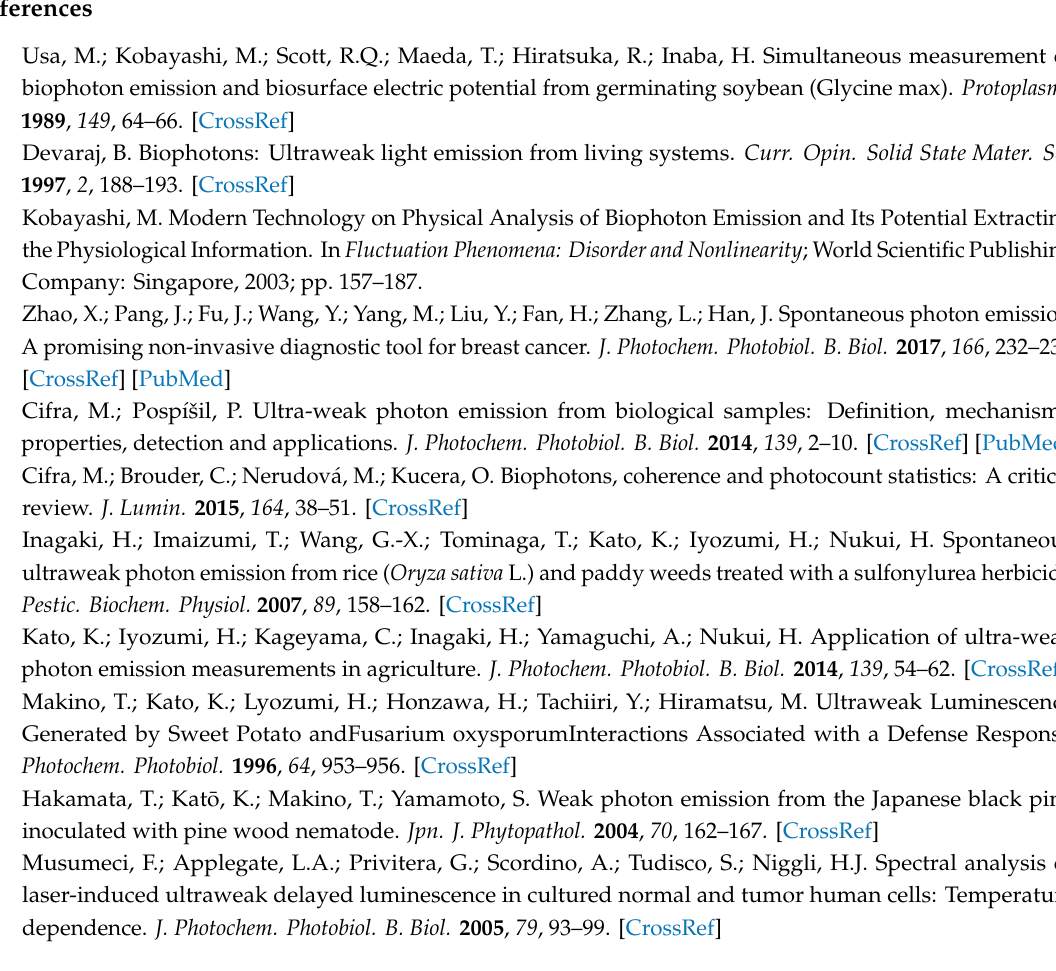
a 30 min accumulation time for each frame (total images: 7). The plants were dark-adapted under weak green light for a period of 2 h before the measurement. Mechanical injury was done under weak green light and plant was further kept in complete darkness for 30 min before measurement. Figure S3: Delayed luminescence from Arabidopsis leaf and its decay monitored for 30 min. The data show the level of dark count and background noise of the PMT (grey box). The arrow indicates the point at which the PMT shutter was closed to assure that the level of noise does not change with time. Figure S4: Biological replicates showing the fluctuation in delayed luminescence. The red dot in A and B indicates mechanical injury. The grey box in B shows opening and closing of the dark box during the measurement to make sure that no external noise was created during the process of wounding. All other conditions remain as in Figure 3C. Table S5: Table S5 showing raw data used in Figure 6 (red) and Figure 7 (blue). The data show averaged BE and TE derived as average from the seven leaves selected for analysis. The first row is the control data, the data from the cycle just before the mechanical injury. Rows C1–C9 are the data from the nine cycles after the mechanical injury. Each entry in the table is the average of the corresponding data of seven selected leaves. The data marked as red in the first table were used for Figure 6A and the one marked blue in the table two were used for Figure